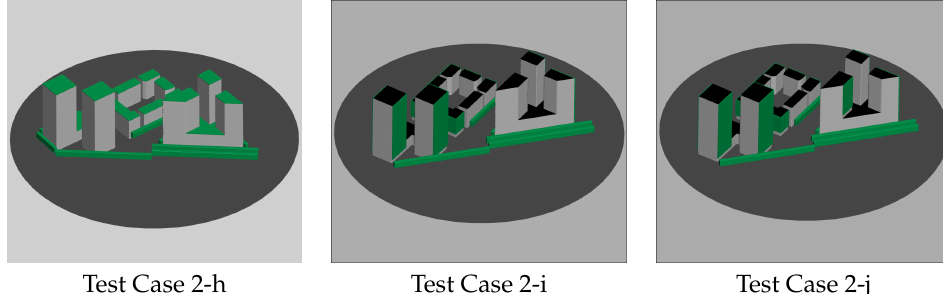
Figure 3. Geometry for Test Case 2 with mitigation